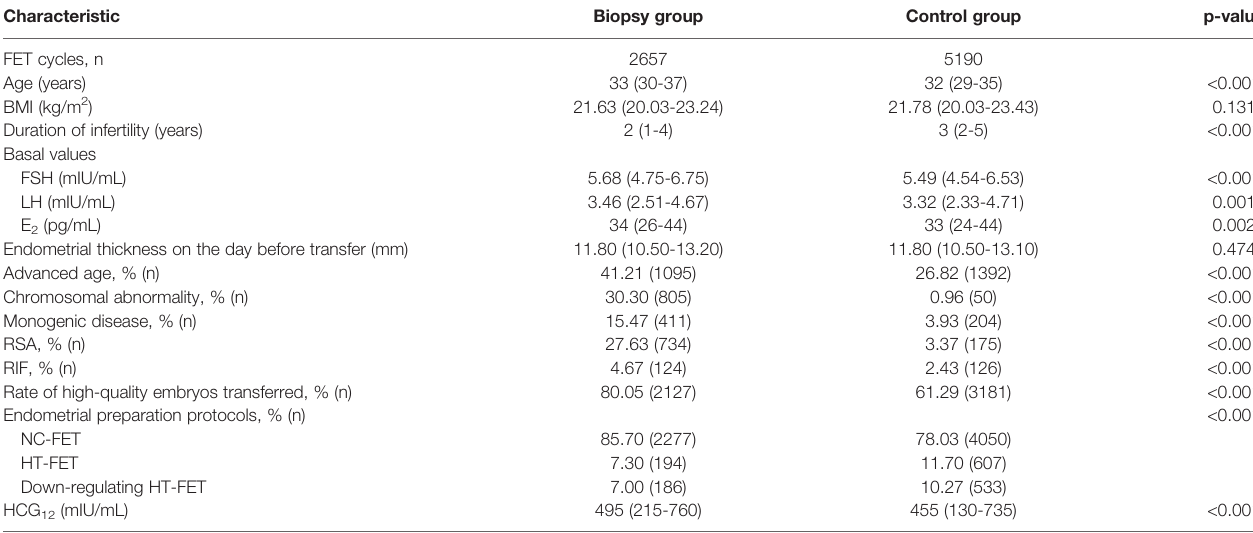
TABLE 1 | Baseline characteristics of cycles with HCG 12 ≥ 7